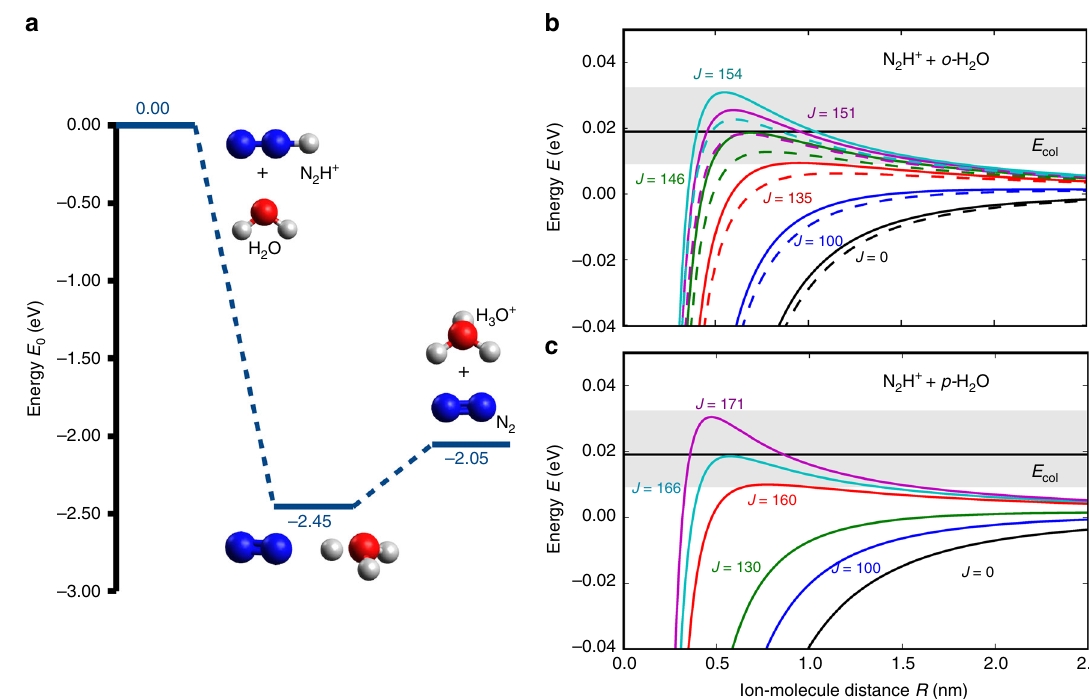
Fig. 4 Theoretical predictions from ab initio calculations and adiabatic capture theory. a Potential-energy pro fi le along the reaction coordinate for the proton transfer reaction between N 2 H + and H 2 O at the CCSD/aug-cc-pVTZ level of theory. The relative energies with respect to the reactants as well as the structures of the stationary points are shown. Blue, red and white spheres represent nitrogen, oxygen, and hydrogen atoms. b , c Rotationally adiabatic, centrifugally corrected long-range interaction potentials for the reaction of the ground states of o- ( b ) and p- ( c ) H 2 O with N 2 H + for different values of the total angular momentum quantum number J . In b , the dashed (solid) lines correspond to the | Ω | = 0(1) components of the ortho- ground state. The grey-shaded areas show an estimate of the uncertainty in the experimental collision energy E col indicated by the black horizontal